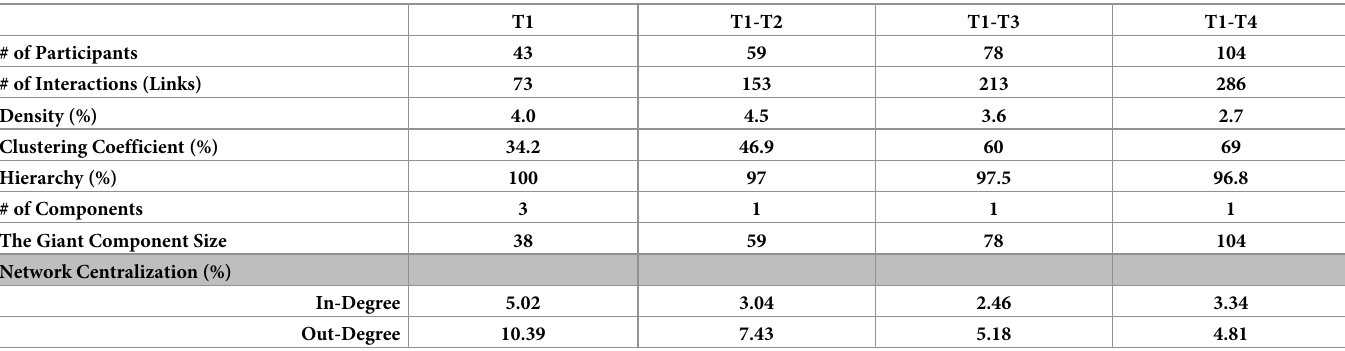
Table 1. Cumulative inter-personal coordination network statistics and